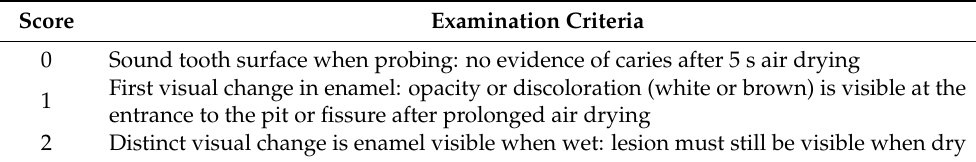
Table 1. Visual examination criteria according to